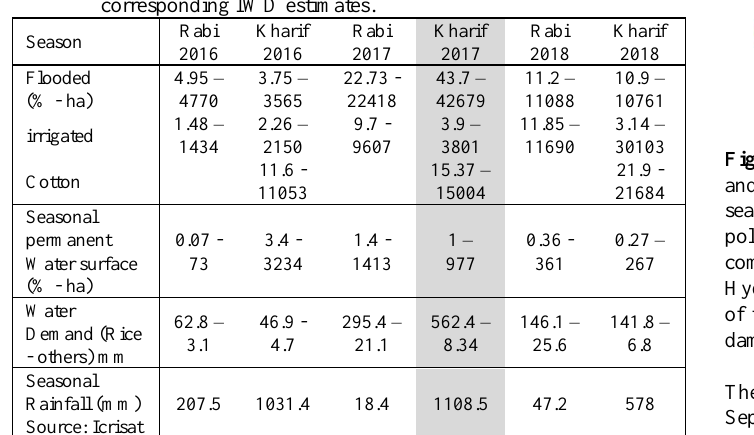
Table 2. Areas of irrigated and flooded crops and corresponding Irrigated Water Demand (IWD) inside the watershed (around 1000km 2 ). Crop areas are expressed both in % of the total watershed area and in ha. IWD are expressed in mm/season, the corresponding water total over the watershed area. This total should be compared to rainfall, also expressed in mm. Surface water is expressed in percent of the total area.